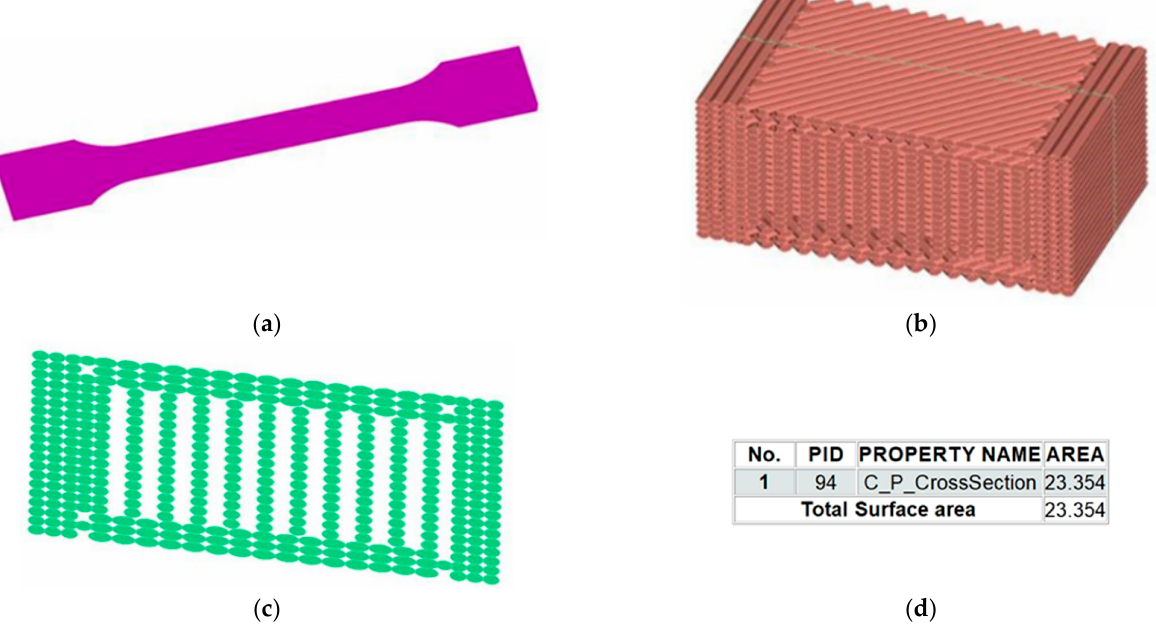
Figure 4. Geometrical modeling and cross-section extraction in ANSA software: ( a ) geometry of the tensile specimen; ( b ) geometrical representation of the filaments; ( c ) cross-section of the geometrical model; ( d ) the result of the area calculation for the cross-section.